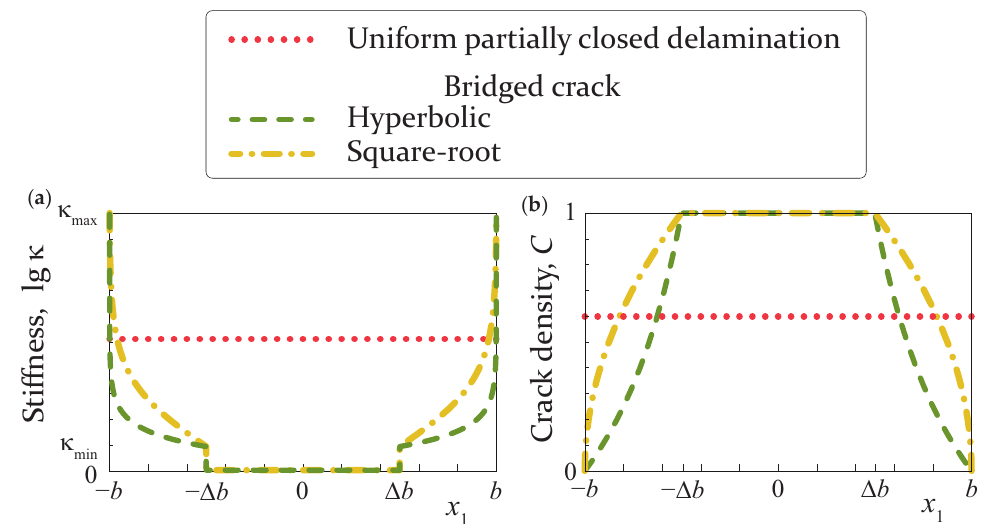
Figure 3. Spring stiffness distribution κ ( x 1 ) ( a ) and the crack density C ( x 1 ) ( b ) for the considered kinds of partially closed